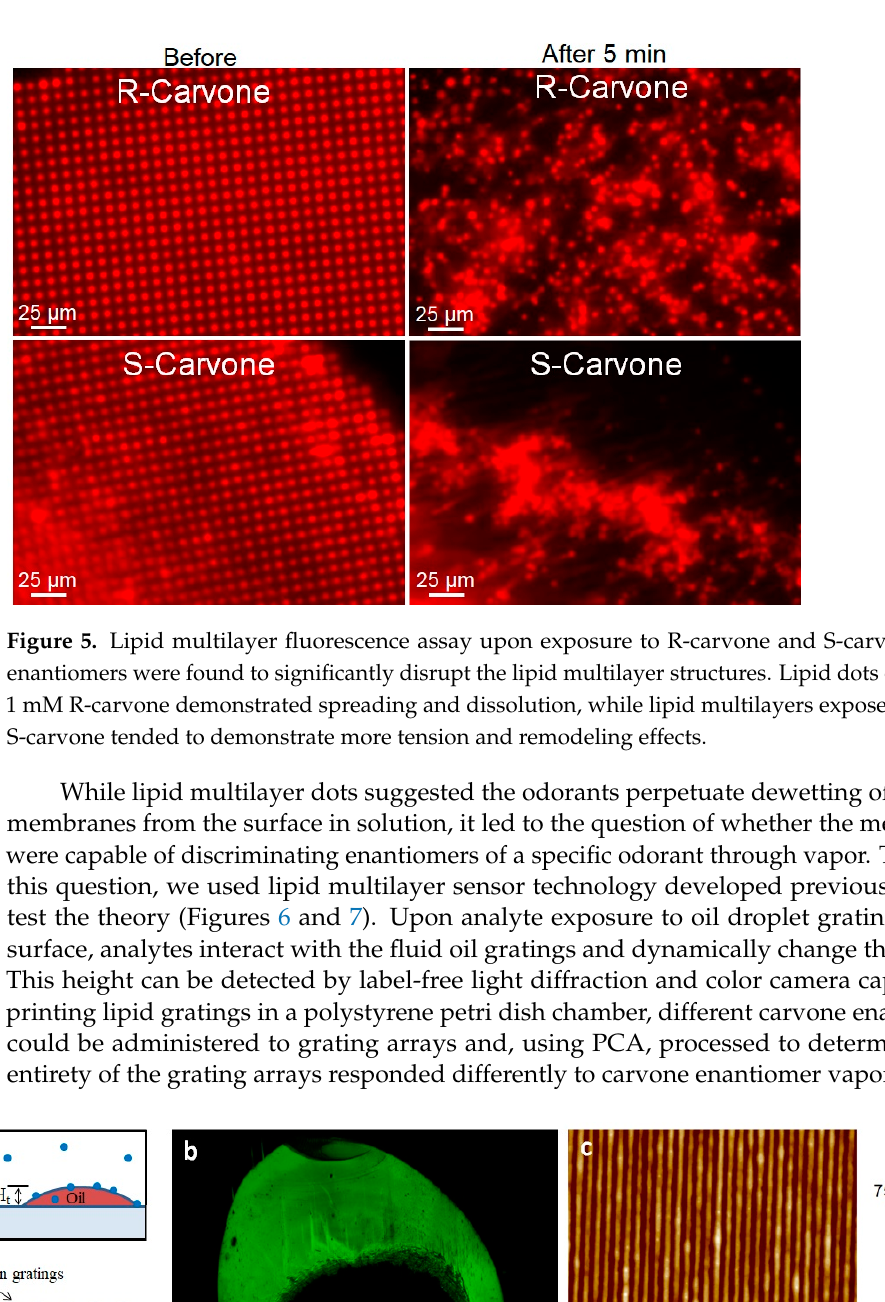
7 of 13 Figure 4. Schematic illustration of a lipid multilayer fluorescence assay. Fluorescently-labeled arrays of lipid droplets on a surface can be observed with a fluorescence microscope. Upon exposure to an analyte, the change in intensity or structure of the lipid arrays is monitored. To further study this phenomenon, 1 mM solutions of R- and S-carvone in 0.5 mol% DMSO were introduced to the lipid multilayer dot structures. As opposed to the hydro- philic odorant lilial, both carvone enantiomers perpetuated dewetting of the phospholipid multilayers that were physisorbed to the glass substrate (Figure 5). To further study the enantiomer selectivity by DOPC membranes, a dose–response was calculated by measur- ing the fluorescence intensity of multilayer dots both before carvone addition and after